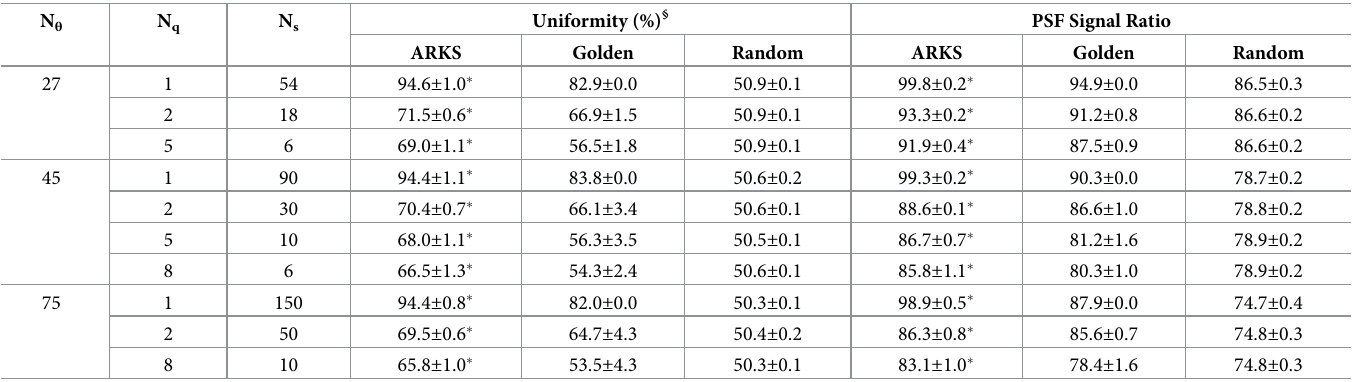
§ Uniformity (Eq 12) compares the performance of the radial acquisition to the ideal distribution (Eq 9). � indicates significant (p < 0.05) difference between ARKS and golden approach. N ARKS = autonomous radial k-space sampling, GA = golden angle, PSF = point spread function.